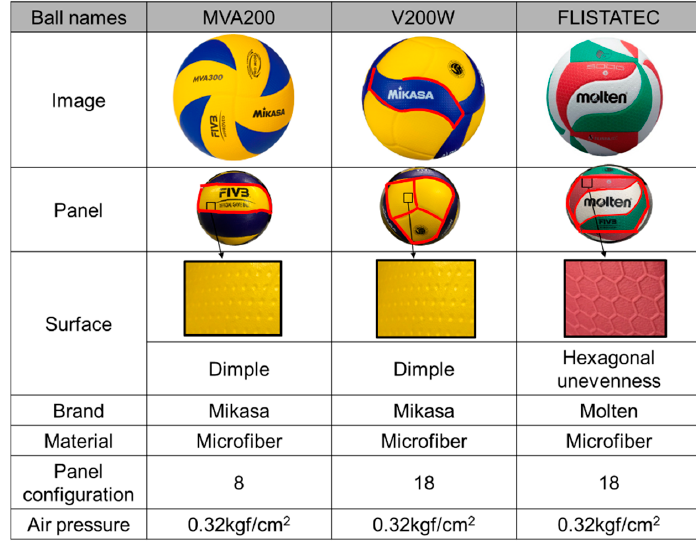
Figure 1. Three types of balls in the measurement.